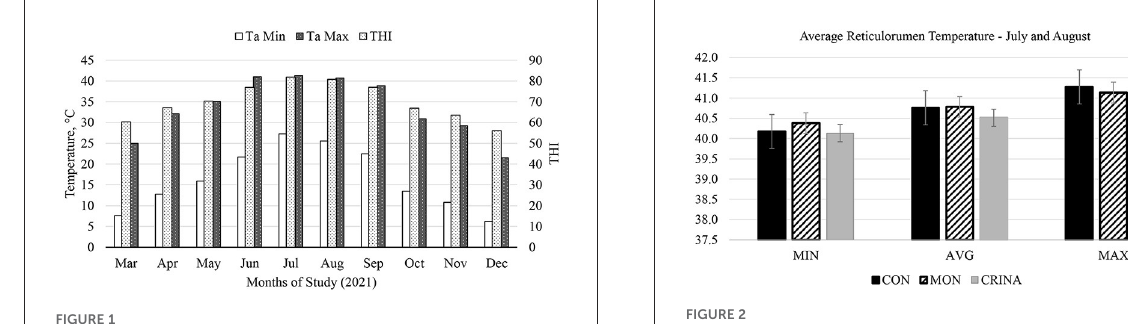
FIGURE1 Temperature-humidity index (THI) during the course of the 286-d feeding period: THI 46.4, where Ta is air temperature ( ◦ C) and H is relative humidity + (Thom, 1959; NOAA, 1976); Min, minimum; Max, maximum.